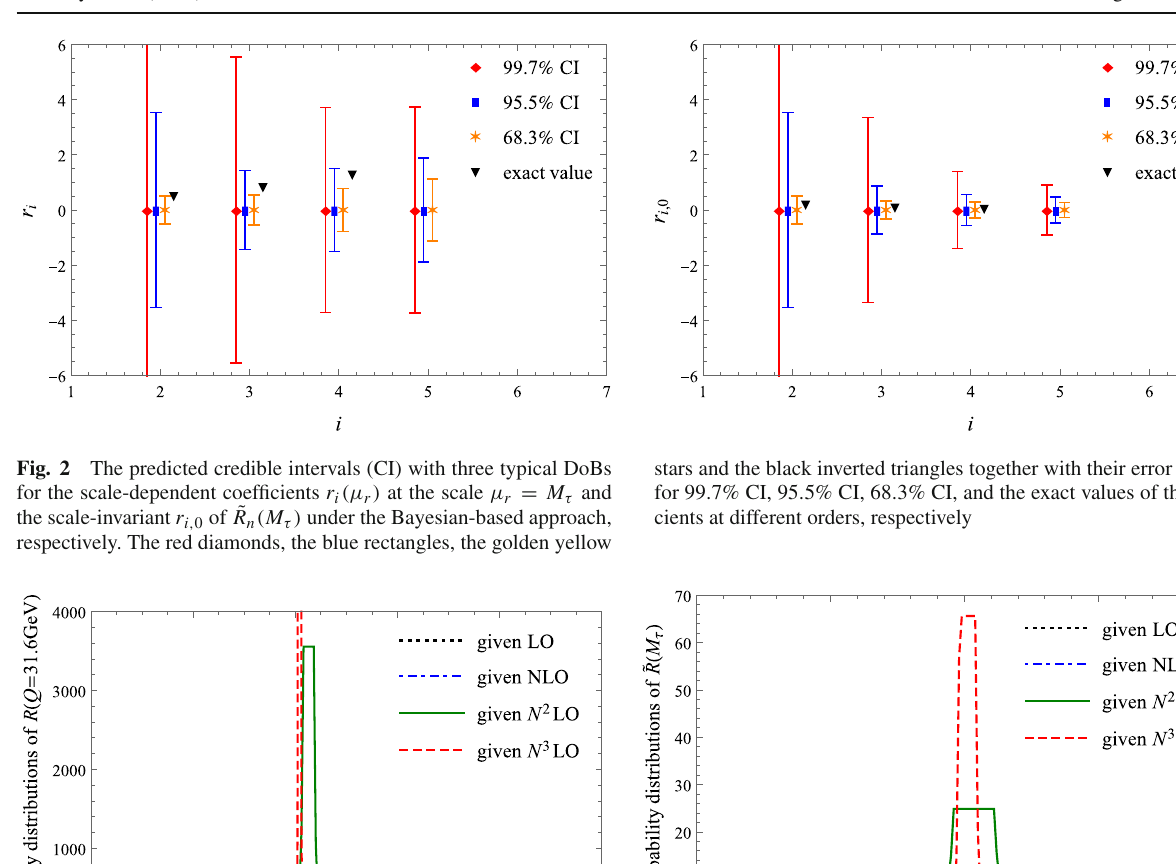
Fig. 3 The probability density distributions of R ( Q = 31 . 6 GeV ) dash-dotted, the green solid and the red dashed lines are results for the and ˜ R ( M τ ) with different states of knowledge predicted by PMCs and given LO, NLO, N 2 LO and N 3 LO series, respectively the Bayesian-based approach, respectively. The black dotted, the blue ˜ R n − 1 ( Q ) ; The conclusions for R n ( M τ ) are similar.